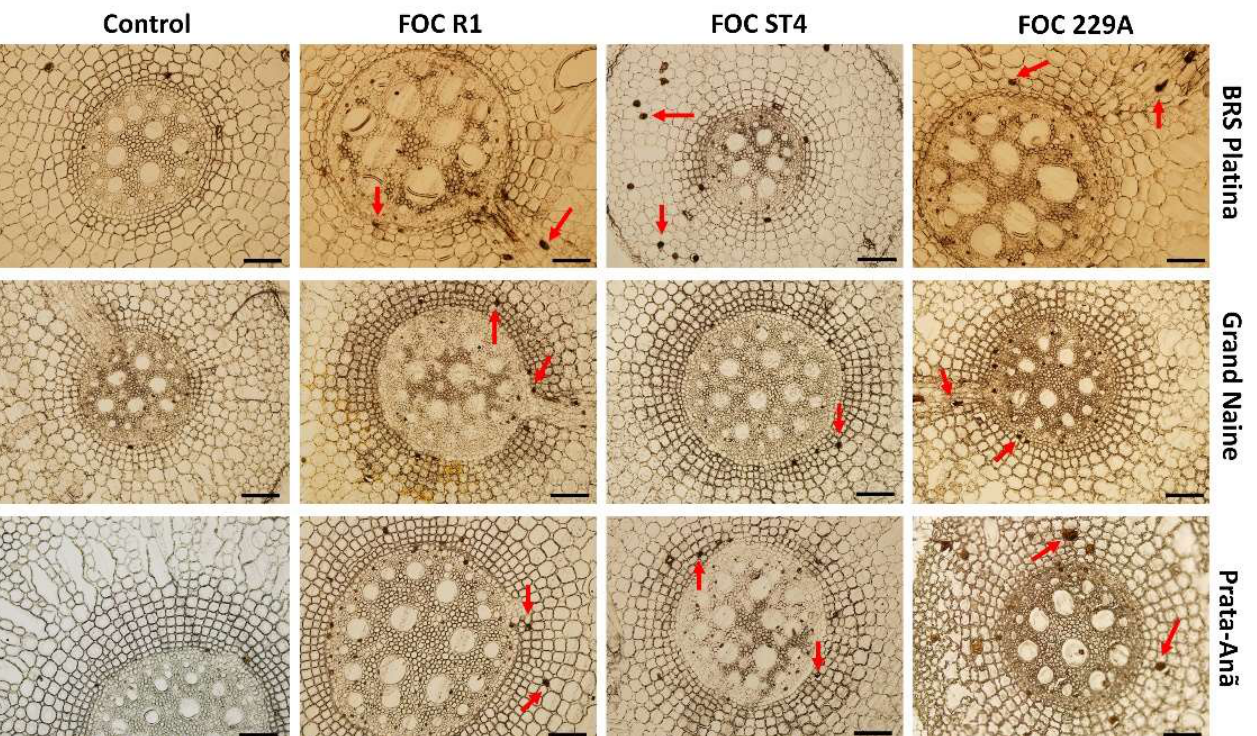
Figure 5. Cross-sectional micrographs of roots of banana cultivars with xylem cavities infested by different Fusarium oxysporum f. sp. cubense strains 12 h after inoculation (HAI) and stained with ferric chloride for the detection of phenolic compounds. Red arrows indicate sections with accumulation of phenolic compounds. Foc: Fusarium oxysporum f. sp. cubense. R1: race 1. ST4: subtropical race 4. bars = 200 μm.